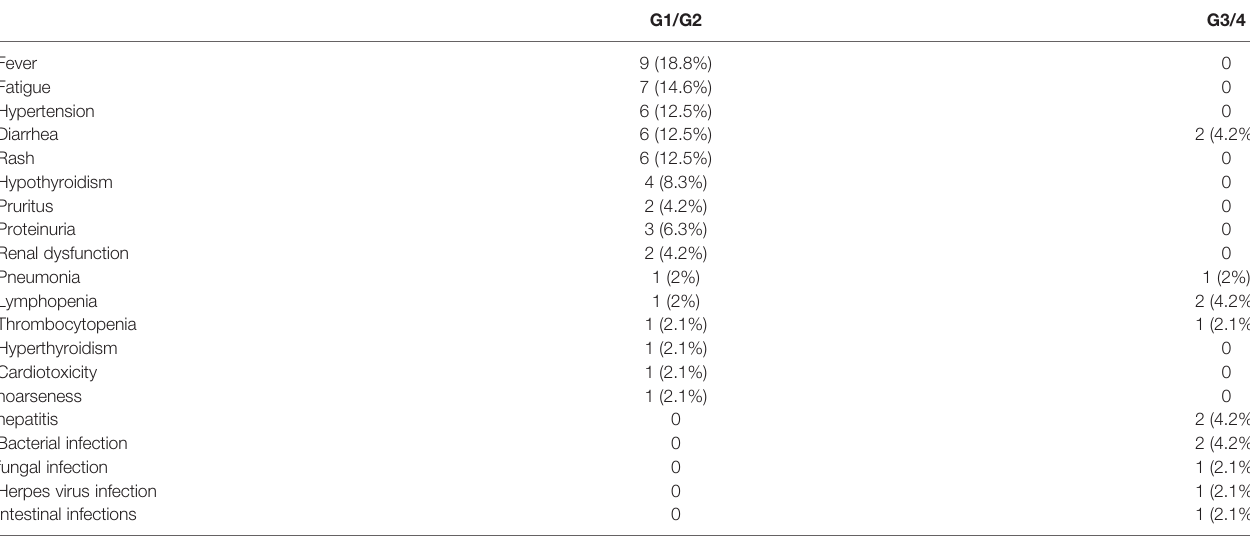
TABLE 2 | Occurrence of adverse